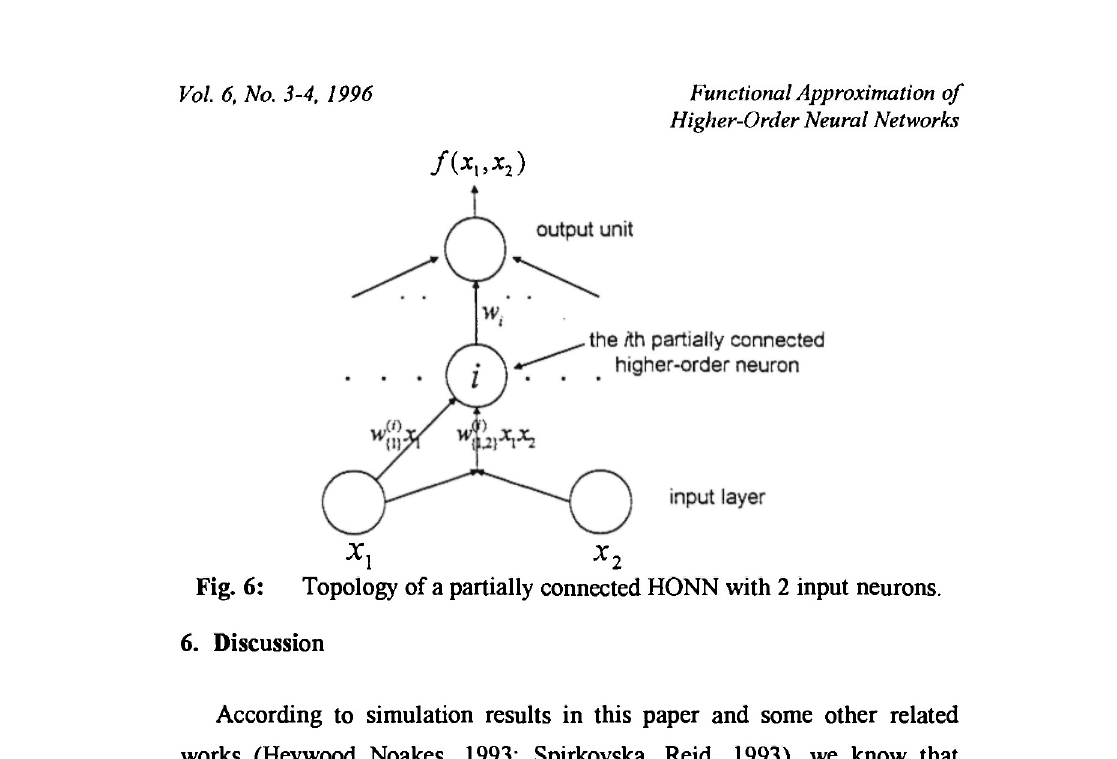
Fig. 6: Topology of a partially connected HONN with 2 input